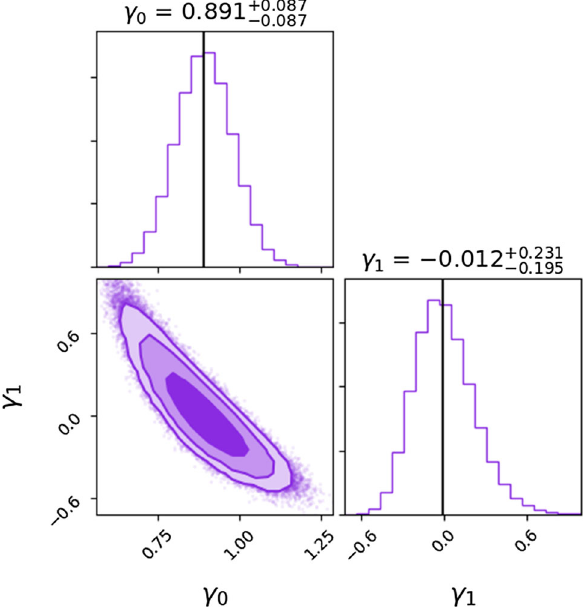
Fig. 1 The 1-D marginalized likelihood distributions along with 2-D marginalized constraints showing the 68%, 95%, and 99% confidence regionsfortheparameters γ 0 and γ 1 ,obtainedusingthe Corner python module [62]